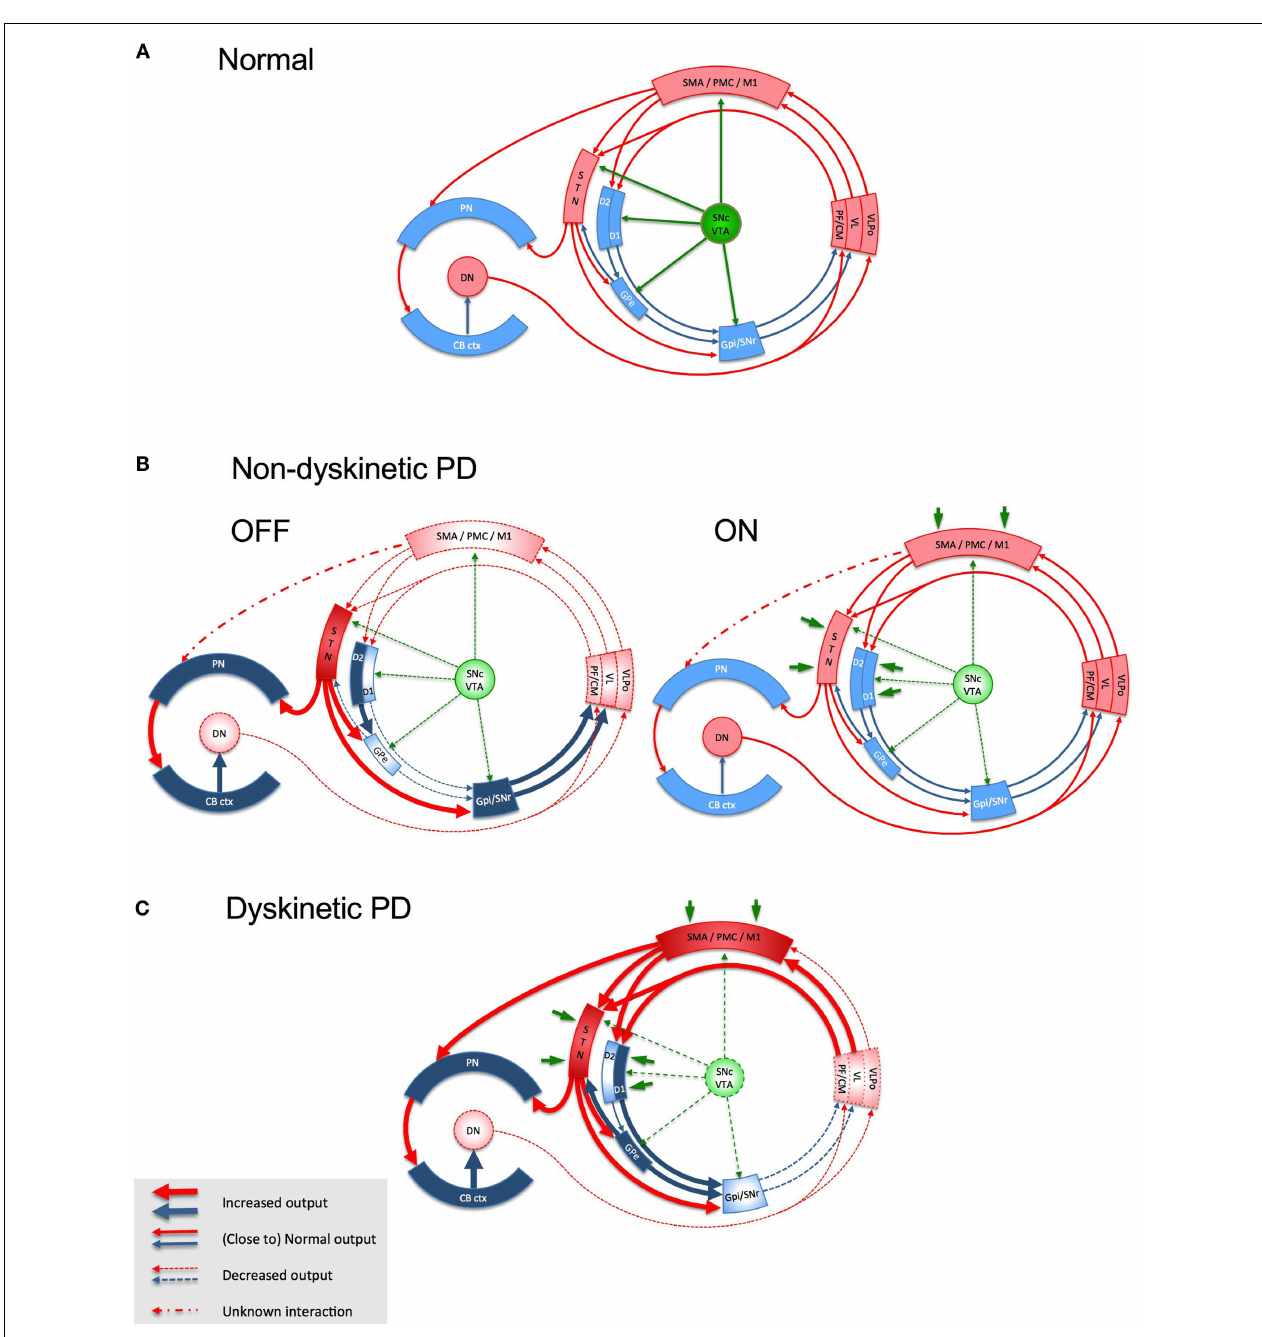
cortex in a persistent hyperactive state and interferes with its sensory processing function.The behavior of the cortico-ponto-cerebellar projections in non-dyskinetic PD in ON is not reported so far and is predicted by this model to be close to normal (CB ctx, cerebellar cortex; CM, centromedian thalamic nucleus; D1/D2, dopamine receptor types of the striatal medium spiny neurons (MSNs); DN, dentate nucleus; GPe, globus pallidus externus; GPi, globus pallidus internus; M1, primary motor cortex; PF, parafascicular nucleus; PMC, premotor cortex; PN, pontine nuclei; SMA, supplementary motor area; SNc, substantia nigra, pars compacta; SNr, substantia nigra, pars reticulata; STN, subthalamic nucleus;VL, ventro-lateral thalamic nucleus;VLPo, ventro-latero-posterior thalamic nucleus, pars oralis;VTA, ventral tegmental